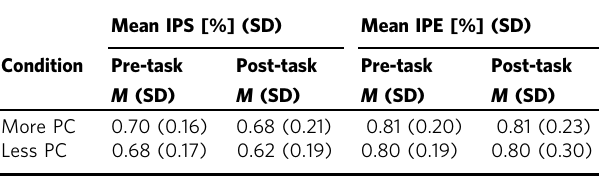
Table 5 Mean and standard deviation of index of preference for social scene and index of preference for eyes in the more physical contact and less physical contact conditions.